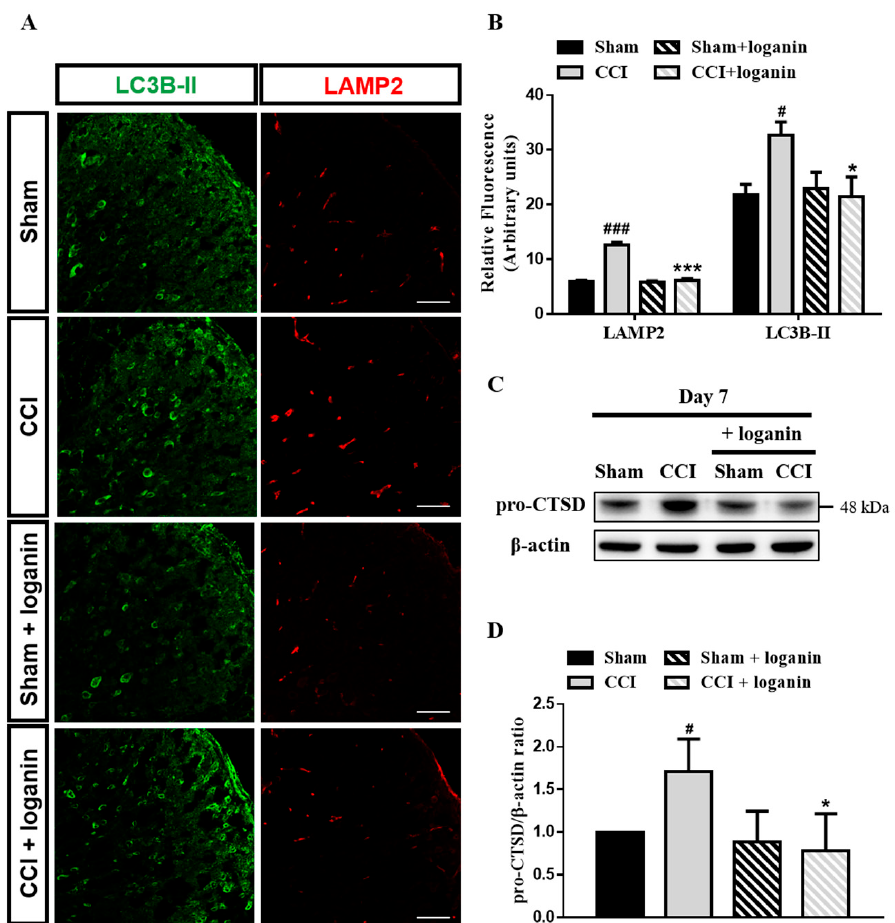
Figure 4. Effects of loganin (5 mg/kg/day, i.p.) on CCI-induced lysosomal dysfunction. ( A ) Repre- sentative images of IHC staining for autophagosome marker LC3B-II (green) and lysosome marker LAMP2 (red) in the spinal cord. The scale bar is 50 µ m. ( B ) Quantification of LAMP2 and LC3B-II signals in ( A ). ( C ) Representative Western blot analysis of lysosomal protease Cathepsin D protein. ( D ) Quantification of Western blot data in ( C ). Sham-operated rats were the subjects of the same procedure without nerve manipulation. These data represent the mean ± SE for 6 rats per group. # p < 0.05, ### p < 0.001 compared with the sham group at the corresponding time points; * p < 0.05, *** p < 0.001 compared with the CCI group.